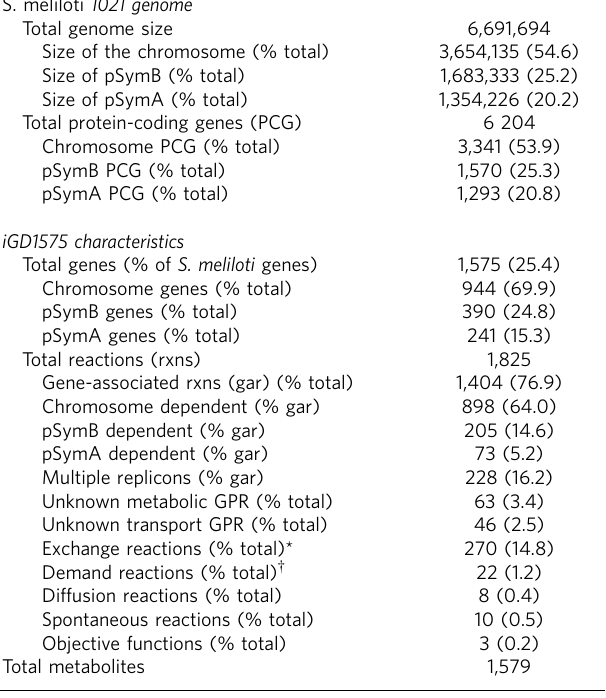
model. In all, 20 of the demand reactions represent the uncharged tRNA molecules, 2 are for fatty